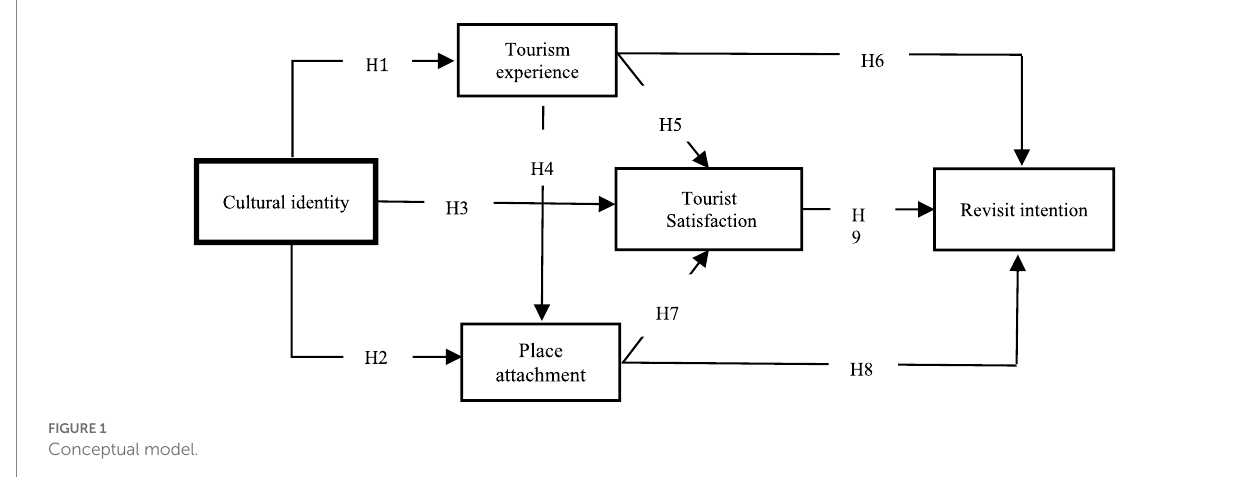
FIGURE 1 Conceptual model.